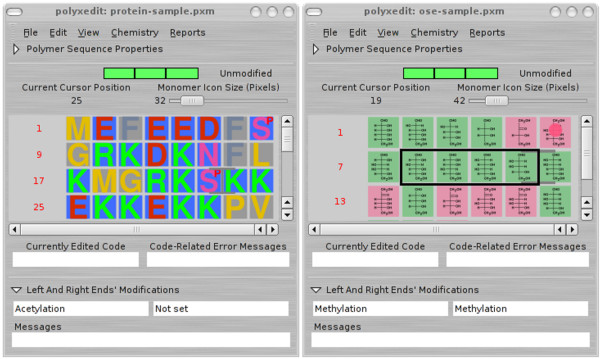
The polyxedit module: the sequence editor. This figure illustrates one of the original features of the polymer sequence editor. The user might configure the software in such a way that the graphical representation of the monomers of a polymer sequence be performed in distinct manners depending on the polymer chemistry. As visible on the figure, the left window represent a protein sequence with each monomer being represented using its 1-letter code. The right window represent an oligosaccharide, for which each monomer is represented with its own chemical formula. The configurability of the display is almost unlimited. Operating the editor feels exactly like using an ordinary text editor. Selection of sequence portions leads to the drawing of a selection polygon with a transparent area (shown in the right sequence editor window screen dump).